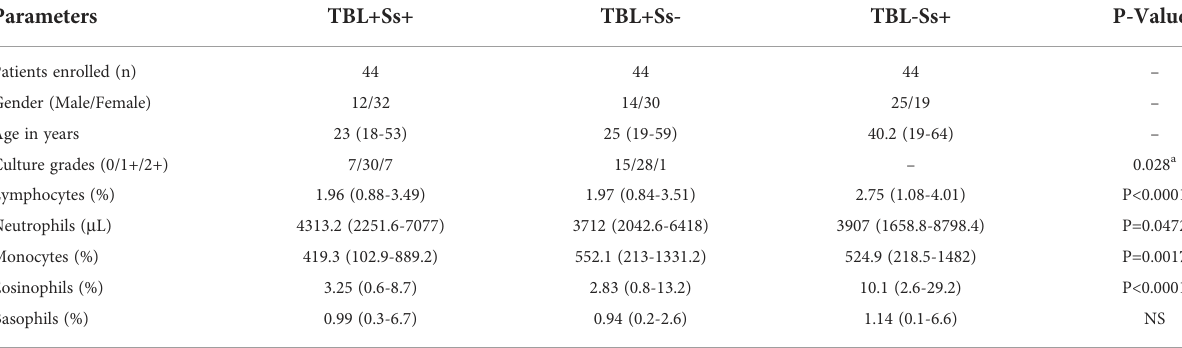
TABLE 1 Study demographics and hematological parameters of the individuals.